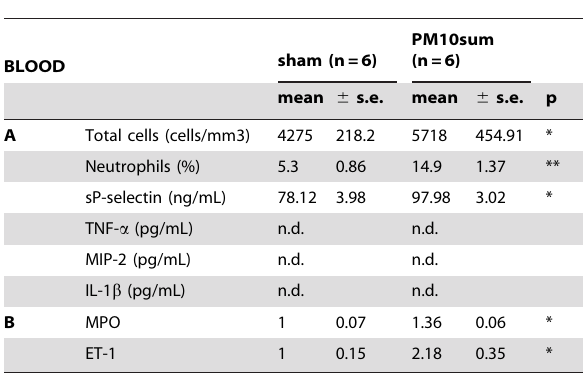
Table 4. Blood gene expression.